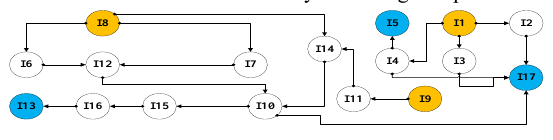
Figure 9 . Simplified interaction dependency network.